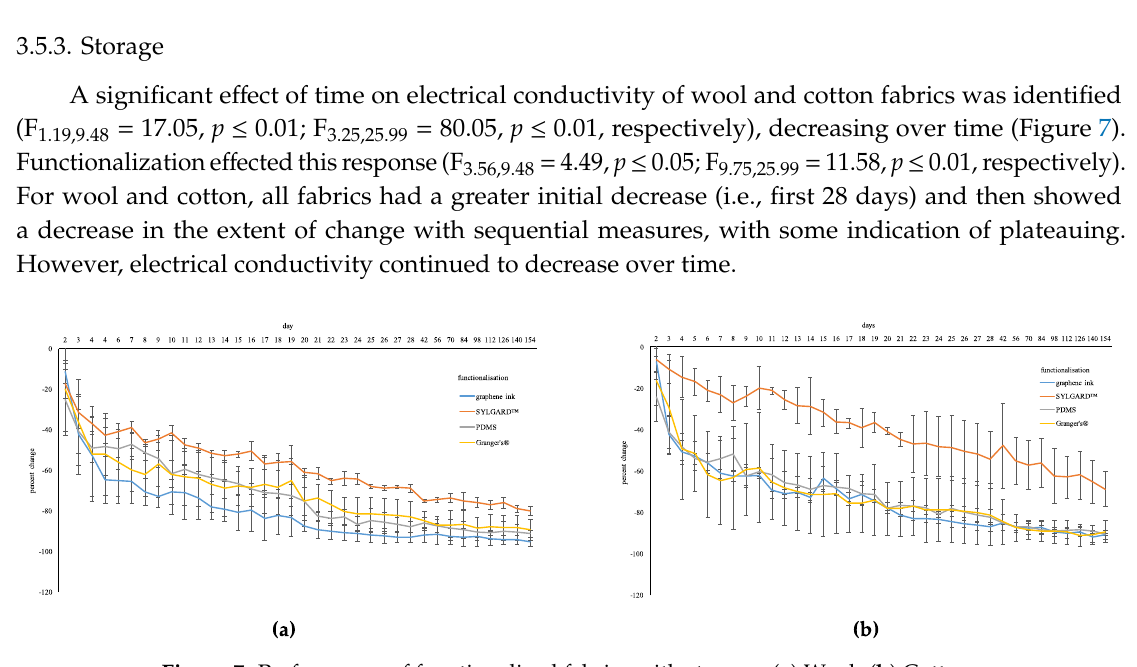
Figure 7. Performance of functionalized fabrics with storage. ( a ) Wool. ( b ) Cotton.